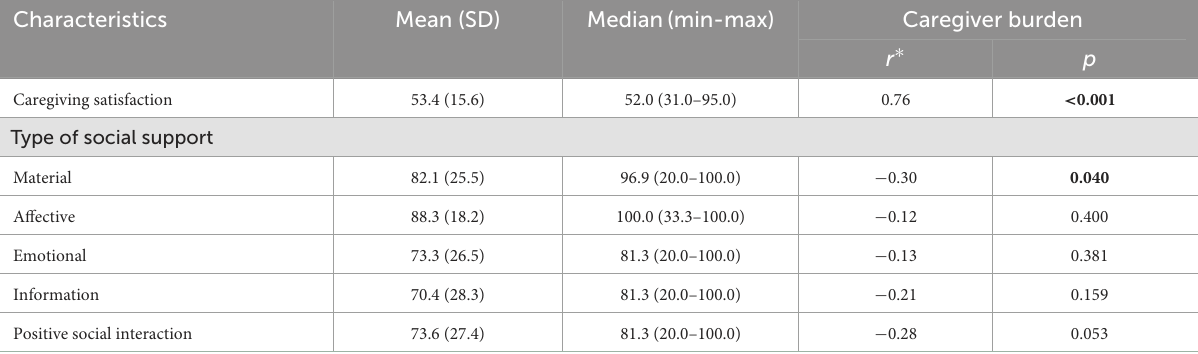
TABLE 3 Correlation between caregiver burden, caregiving satisfaction, and social support. Palmas, Tocantins, Brazil. 2020–2022 ( n = 52).